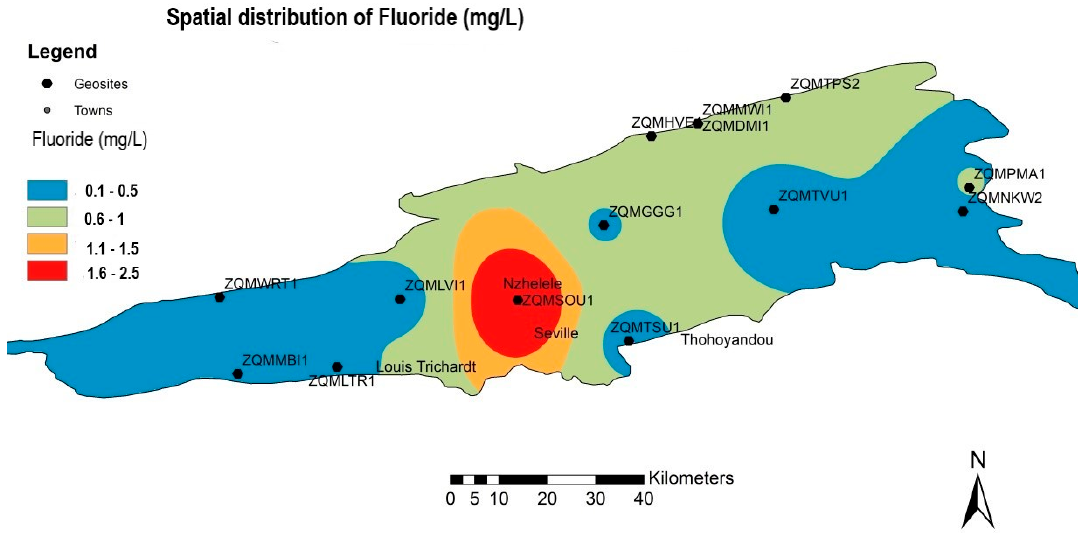
Figure 6. Spatial distribution of fluoride in the Soutpansberg region.